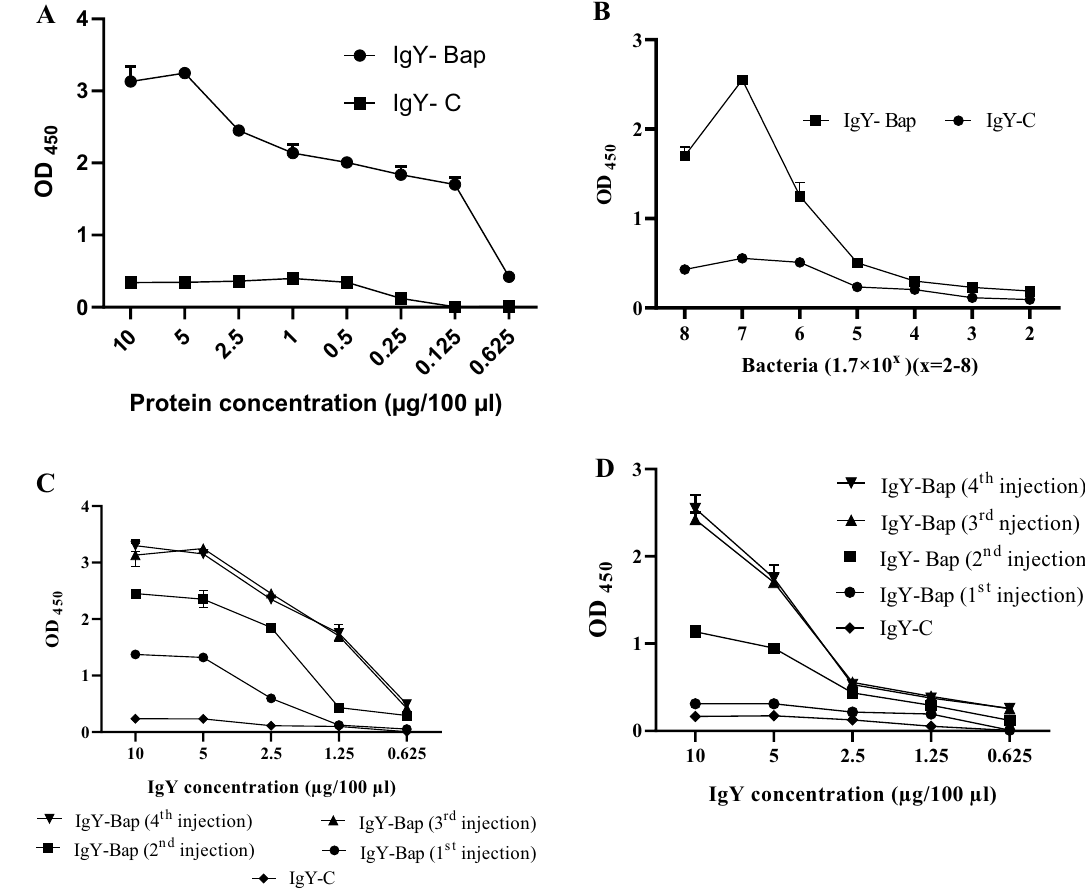
Figure 2. Indirect ELISA. ( A ) Effect of protein concentration in indirect ELISA against 10 µg IgY. ( B ) Effect of bacterial load in whole-cell ELISA against 10 µg IgY. The horizontal axis shows the number of bacteria ranging from 1.7 × 10 2 to 1.7 × 10 8 . ( C ) Indirect ELISA of IgY against 5 µg of Bap coated in each well. ( D ) Indirect ELISA of IgY against 1.7 × 10 7 CFU whole-cells of A. baumannii Kh0060 coated in each well. The values represent mean triplicate independent experiments + /− standard error